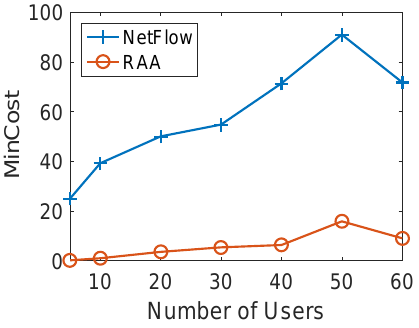
Figure 5. Mincost for varied numbers of users with 10 APs.